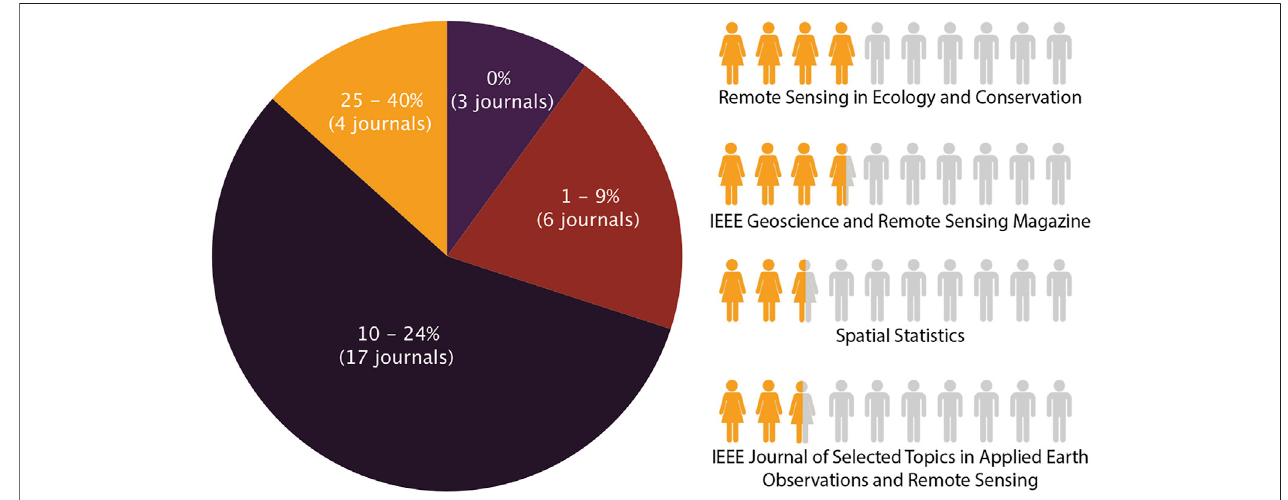
FIGURE 1 | Proportion of women on the editorial boards of 30 peer-reviewed journals in the remote sensing discipline audited as part of this article. The four journals with the highest proportion of women on their boards are also shown.